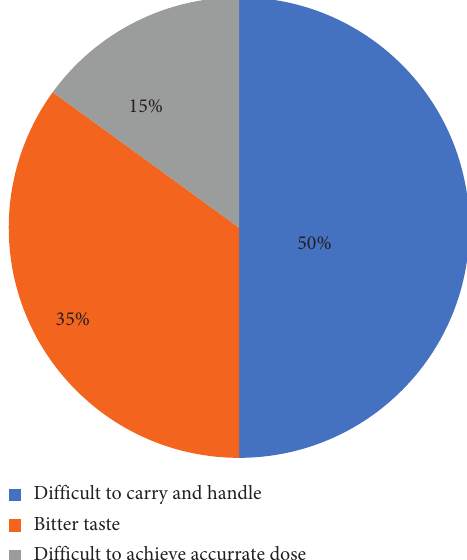
Figure 3: A pie chart showing reasons given by respondents ( n � 150) for not preferring liquid preparations. 50% of the respondents in the Ningo Prampram district indicated that they had difficulty in handling and carrying the liquid preparations and hence they did not prefer this dosage form. 35% of the respondents also indicated that the bitter taste of the liquid preparations deterred them from choosing liquid preparations, while 15% indicated that they did not prefer the liquid preparations because of difficulty in obtaining an accurate Table 1: Maximum wavelength and corresponding absorbance for a dose of liquid and dried powder of the herbal antimalarials. Sample used